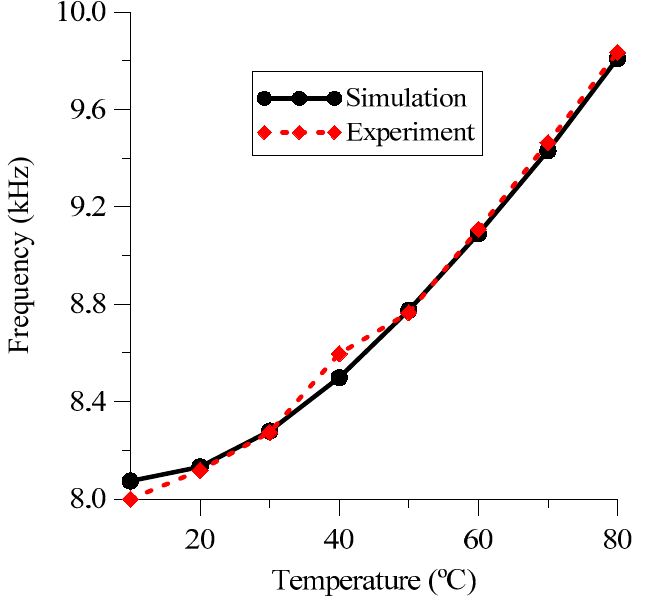
Figure 10. Evolution of the resonance frequency as a function of the temperature. Both experimental measurements and theoretical results (using the previous EEC model) have been included.